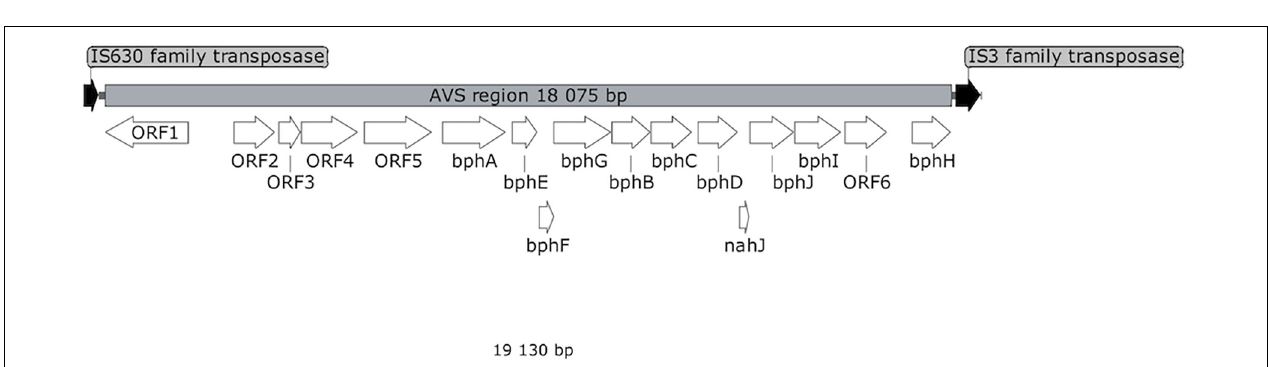
FIGURE 2 | Phylogeny reconstruction of SVs of bphA amplicons in the context of typical ARHD large subunits. Accession numbers shown in brackets. The tree is drawn to scale, branch lengths represent the number of substitutions per site. Bootstrapping was used to test the tree topology (500 bootstraps), only bootstrap values > 50 are shown. The final dataset was comprised of 140 positions.